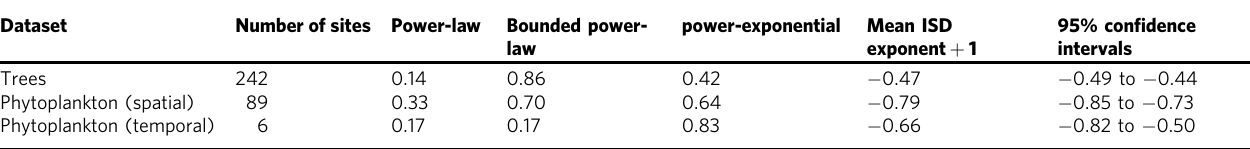
Table 1 Identifying the best- fi tting individual size distribution